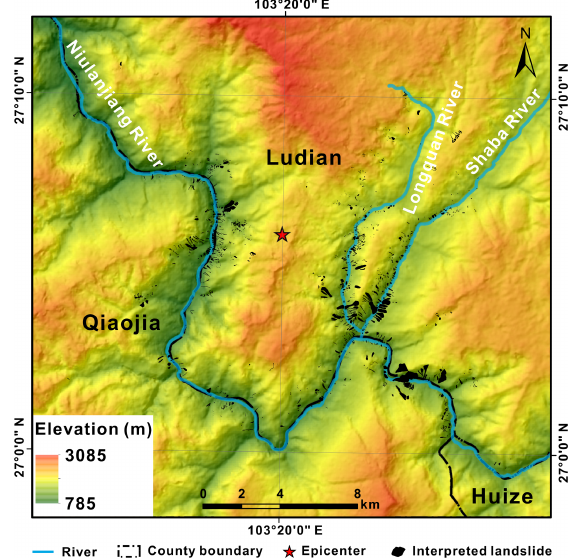
Figure 1. Map of the study area showing the inventoried